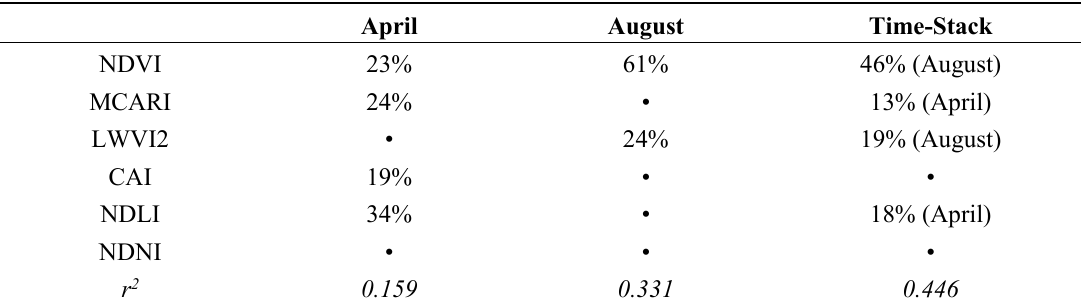
Table 2. Mean model performances (r 2 ) and variable importance (%) in the respective Boosted Regression Trees (BRT) models. Variables not significantly selected by the models have no importance reported. April August